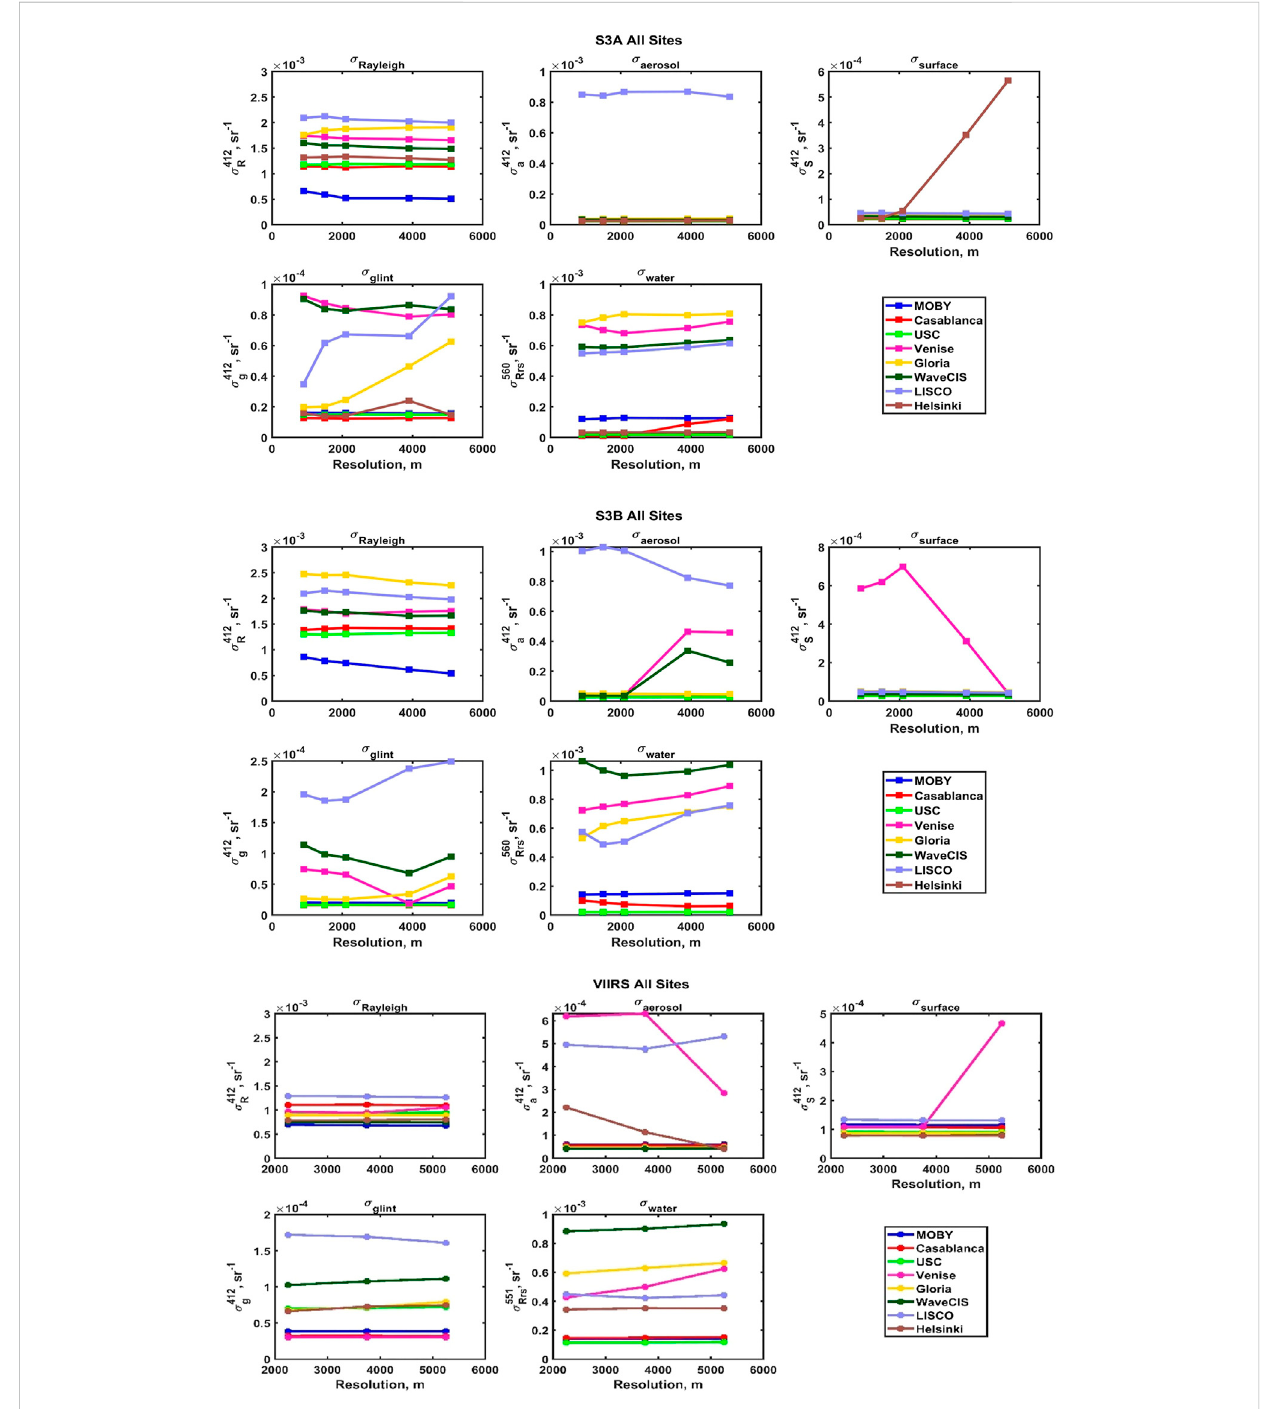
FIGURE 6 Proportionality coef fi cients in Eq. 7 in the form of standard deviations at referenced wavelengths.